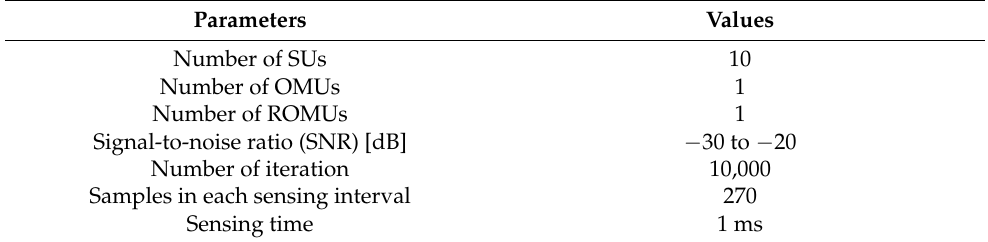
Table 1. Simulation parameters.